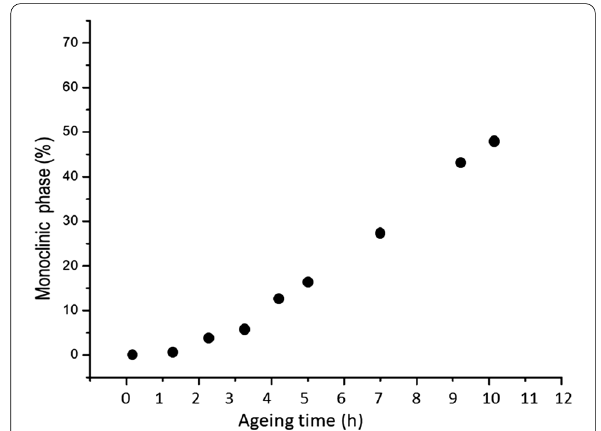
Fig. 6 Monoclinic phase percentage presents in the dental implants in relation to the aging